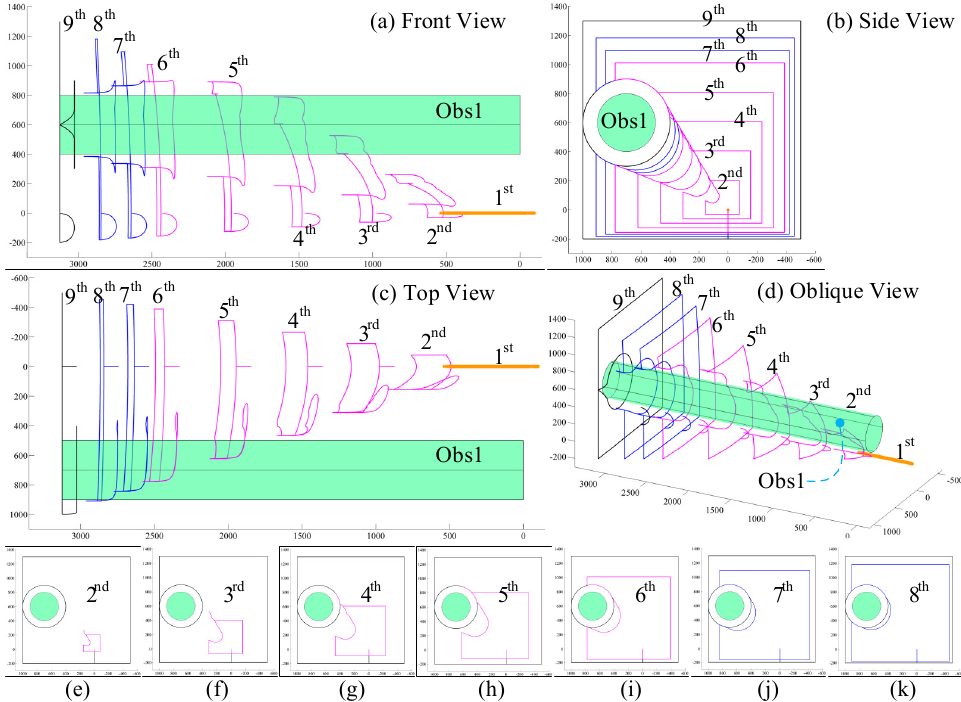
Figure 11. Motion paths of 9 key points in obs1. ( a ) Front view; ( b ) Side view; ( c ) Top view; ( d ) Oblique view; ( e ) Motion projection of 2nd joint; ( f ) Motion projection of 3rd joint; ( g ) Motion projection of 4th joint; ( h ) Motion projection of 5th joint; ( i ) Motion projection of 6th joint; ( j ) Motion projection of 7th joint; ( k ) Motion projection of 8th joint.